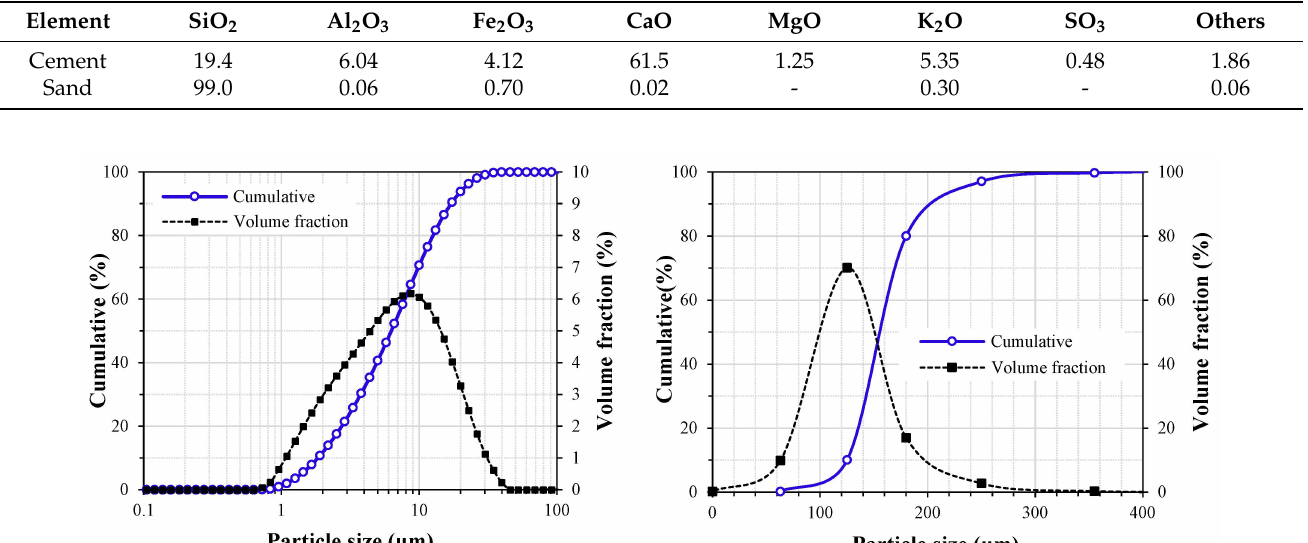
Figure 1. Particle size distribution of ( left ) cement powder; ( right ) sand.